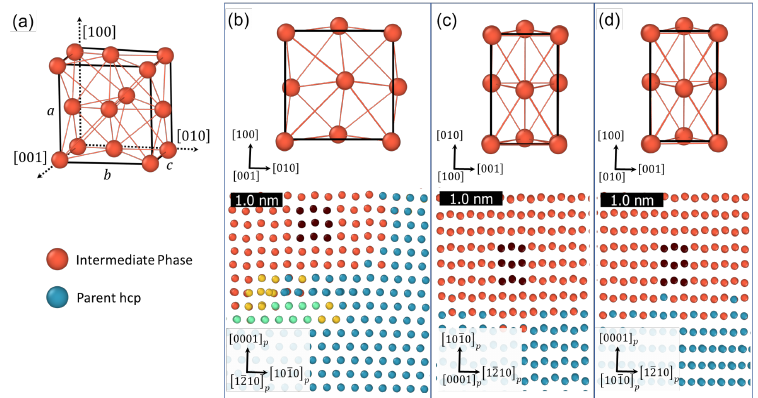
Figure 2. ( a ) A unit cell of the metastable tetragonal phase extracted from our MD simulation. Its different views when projected along ( b ) [001], ( c ) [100], and ( d ) [010] directions. Below each view of the unit cell are thin slices of our MD simulation ( b ) viewed along the common a -axis of the { 10¯12 } extension twin, ( c ) projected onto the parent basal plane, and ( d ) projected onto the parent prismatic plane, in which atoms in one tetragonal unit cell are highlighted in black. The subscript “ P ” represents the parent hcp